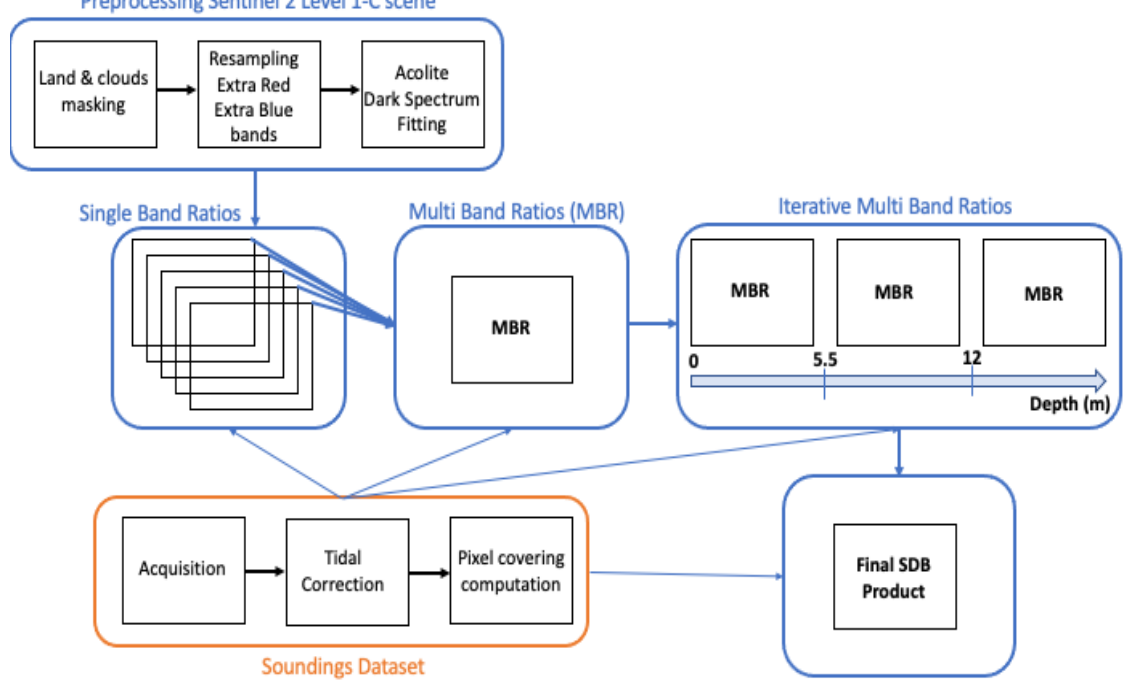
Figure 2. Processing workflow; within its center, the three ratio approaches that are compared here for Poe lagoon.